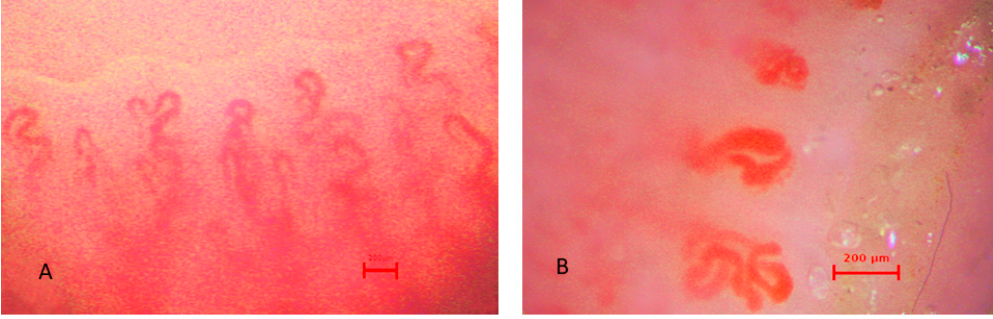
Figure 2. Cont. Figure 2.